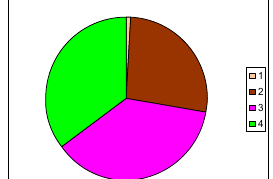
Figure 7. Pie charts of the various classes in 2012: 1-bare surface, 2-built-up, 3-farmland, 4-